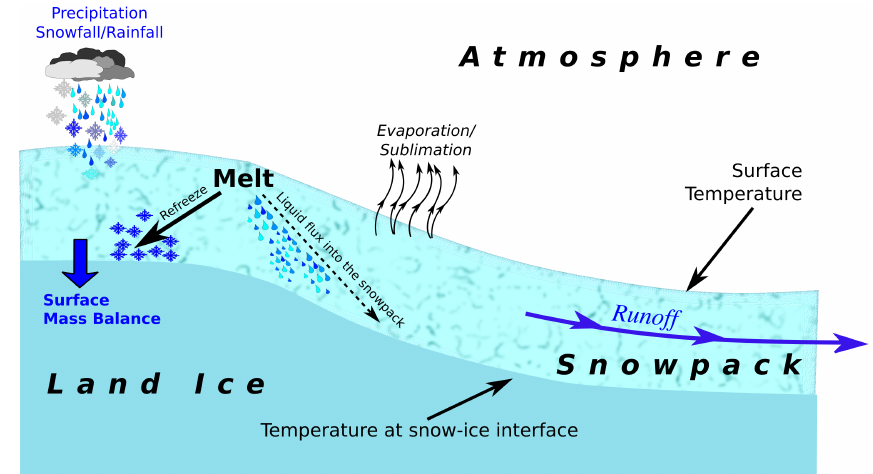
Figure A2. Illustration of key processes needed to compute atmospheric forcing for ice-sheet models and to evaluate the surface mass balance simulated by climate